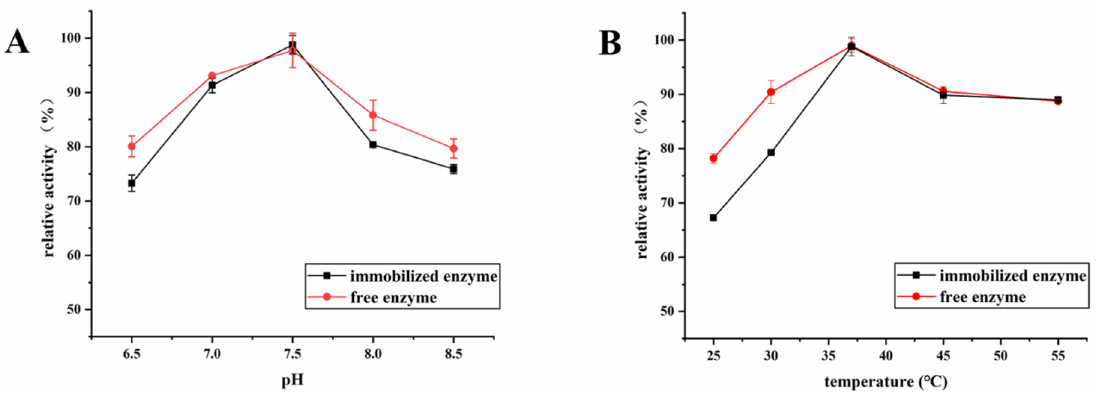
Figure 4. Effects of pH ( A ) and temperature ( B ) on the activity of free XOD and immobilized XOD (the optimal activities of the immobilized enzyme and free enzyme counterparts were taken as 100%).